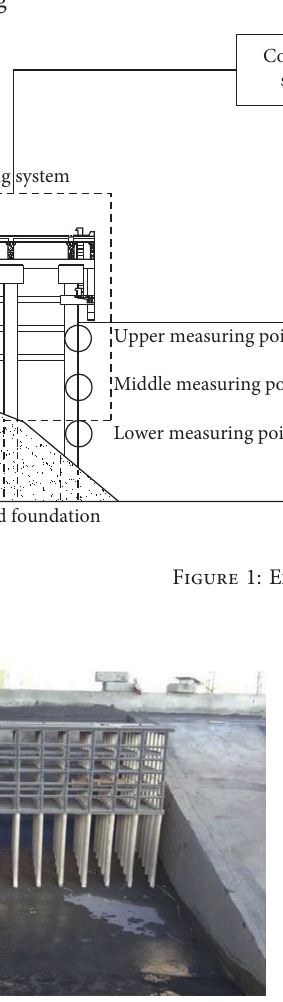
Figure 2: Model of overhead vertical wharf.